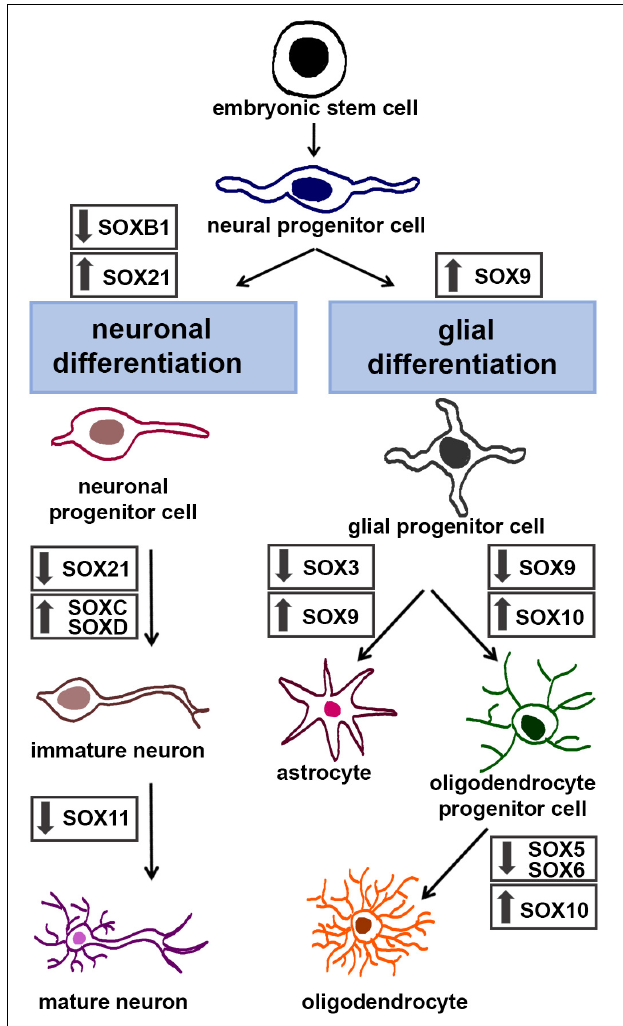
FIGURE 3 | The roles of SOX TFs in neuronal and glial differentiation. Schematic illustration of stepwise neuronal differentiation process (left) and glial differentiation process (right) . SOX TFs expression levels during specific lineage-restricted progressions are presented by down-arrows (down-regulation) and up-arrows (up-regulation). The figure summarizes following data: for neuronal differentiation – (Connor et al., 1995; Bylund et al., 2003; Stolt et al., 2003; Sandberg et al., 2005; Wang et al., 2005; Bergsland et al., 2006; Batista-Brito et al., 2009; Martinez-Morales et al., 2010; Hoshiba et al., 2016; Naudet et al., 2018); for glial differentiation – (Stolt et al., 2003, 2004, 2006; Kellerer et al., 2006; Stolt and Wegner, 2010; Kang et al., 2012; Weider et al., 2013; Klum et al.,